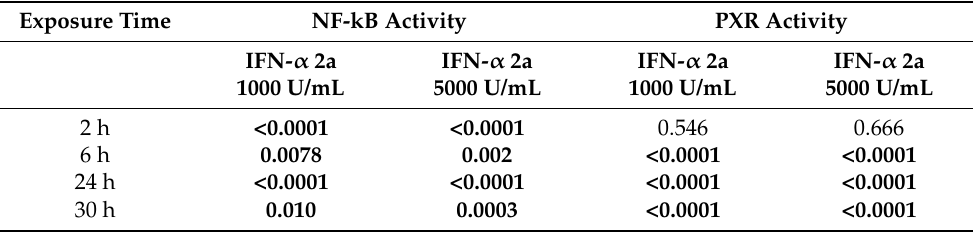
Table 1. Statistical evaluation of relative NF- ĸB and PXR activities after different exposure times of LS180 cells to two different IFN- α 2a concentrations.